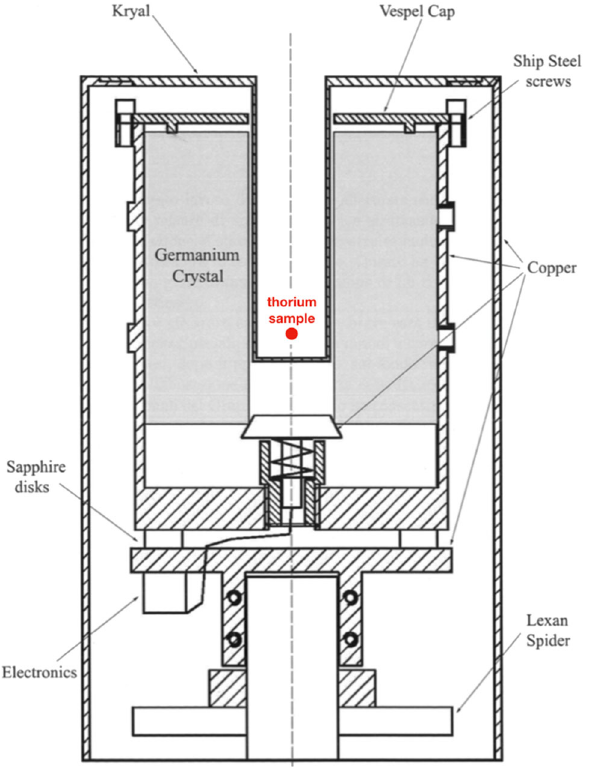
Fig. 2 Setup and sample configuration of the measurement. Figure adopted from [29]